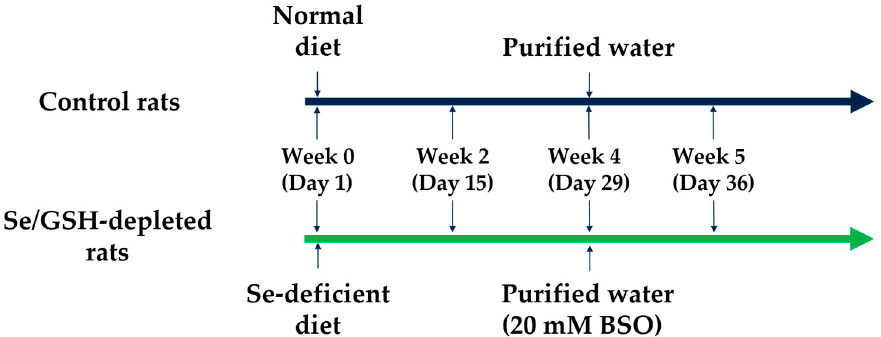
Figure 1. Preparing procedure of selenium / glutathione (Se / GSH)-depleted rats.